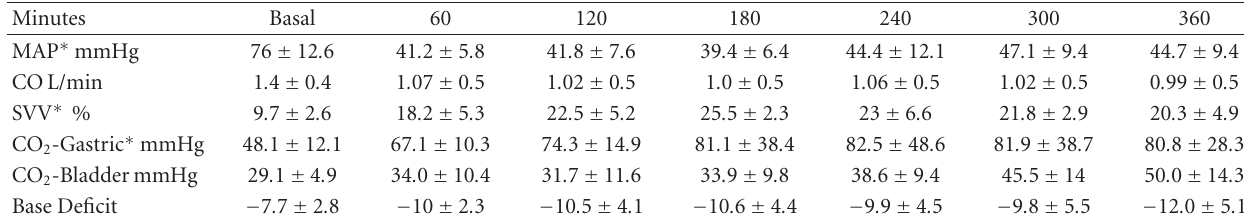
Table 1: Evolution of the hemodynamic parameters from basal to end of follow-up.